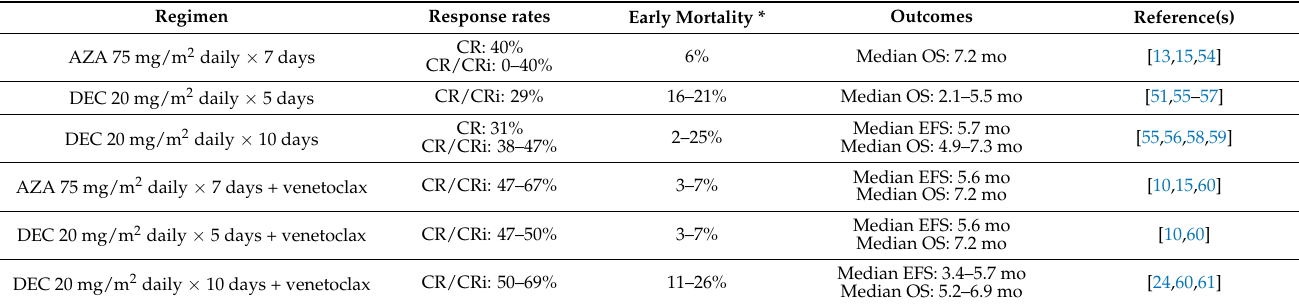
Table 2. Summary of experience with less-intensive therapy for TP53 -mutated acute myeloid leukemia. Regimen Response rates Early Mortality * Outcomes